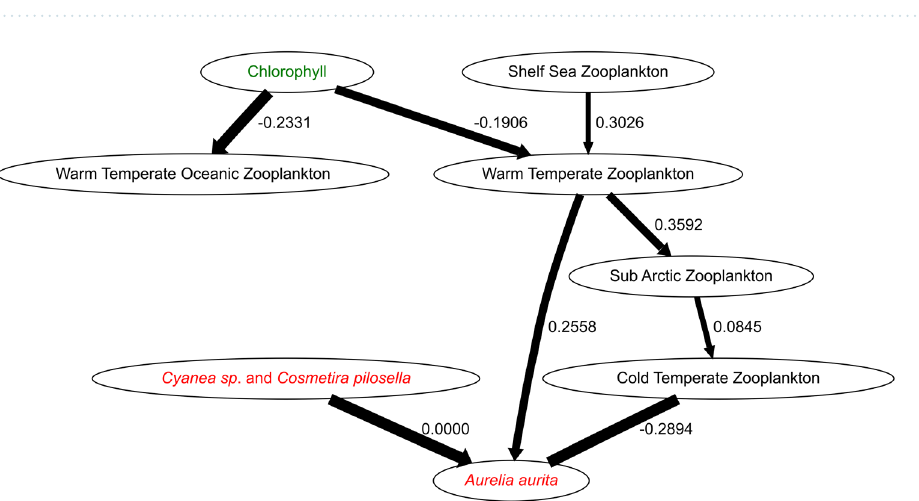
Figure 5. Jellyfish—zooplankton network apparent in the 2008 cruise data. The occurrence rate is indicated by the width of the edge (the line depicting dependencies between two taxa) - the wider the line, the higher the occurrence rate. Arrows indicate non-mutual dependence between two taxa; for example the Sub Arctic Zooplankton group has a positive dependency (is aggregated) with Warm Temperate Oceanic Zooplankton, but Warm Temperate Oceanic Zooplankton do not have a dependency with Sub Arctic Zooplankton. Where there is a mutual dependency between two groups, such as with Cold Temperate Oceanic Zooplankton and Aurelia aurita, the edge does not have an arrow. Numbers by the lines are the mean interaction strengths of the dependencies, with positive interaction strengths indicating aggregation, negative interaction strengths indicating segregation, and zero indicating different aggregation and segregation behaviours at different densities. Phytoplankton abundances are given by Chlorophyll